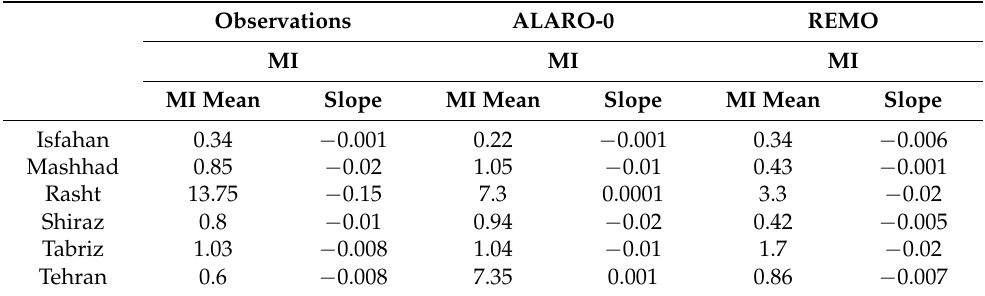
Table 5. Model performance for moisture index (MI) (1980–2017). MI mean: average moisture index during 38 years of study (kg air. mm/kg water). Trend slope: slope of trend during 38 years.